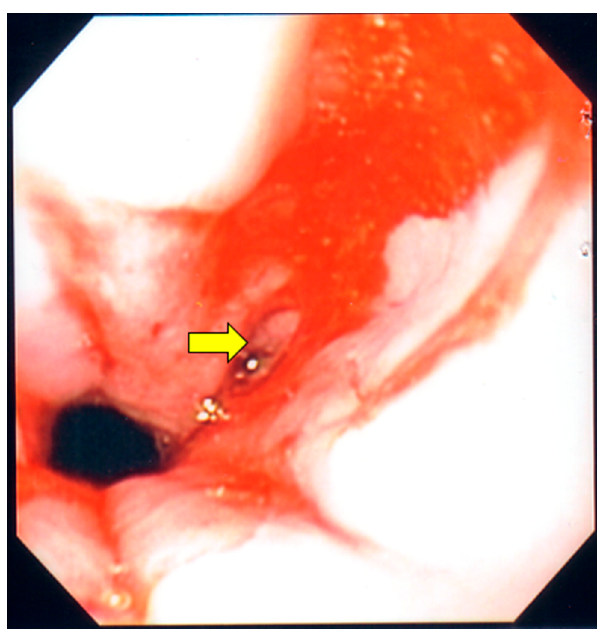
Figure 2. Upper endoscopy. The yellow arrow points to an ulceration found in the mid portion of the esophagus, which was secondary to cytomegalovirus esophagitis.